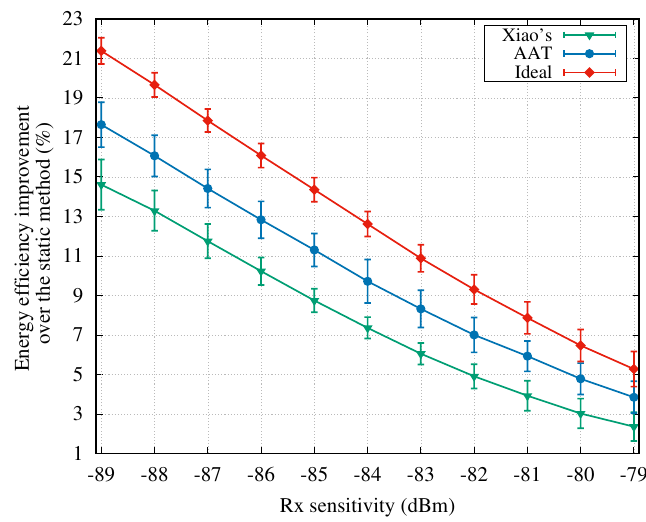
Figure 9. Energy efficiency improvement over the static scheme vs. Rx